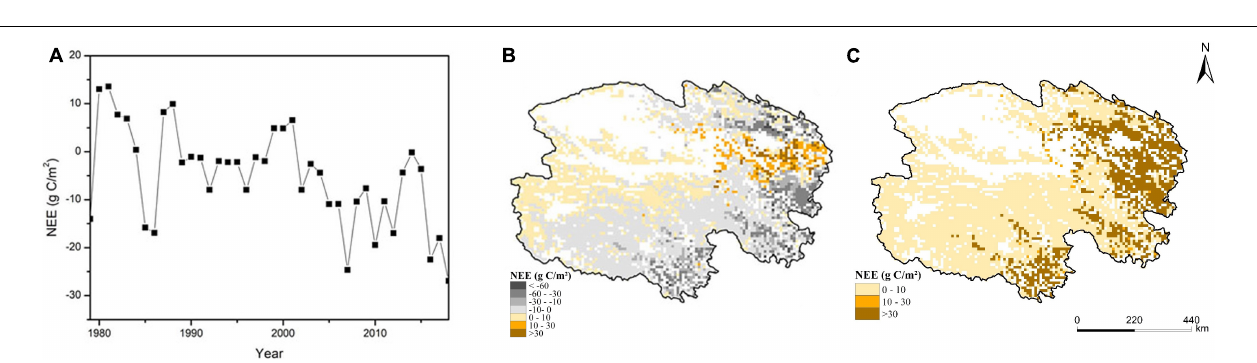
FIGURE 3 | Temporal (A) and spatial (B) dynamics of GPP and the map of its standard deviation (C) in Qinghai grasslands from 1979 to 2018.